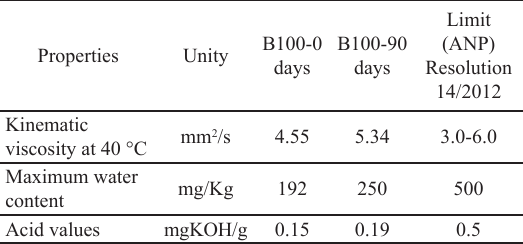
Table 3. Physicochemical parameters of the recently produced soy biodiesel (B100-0 days) and after 90 days (B100-90